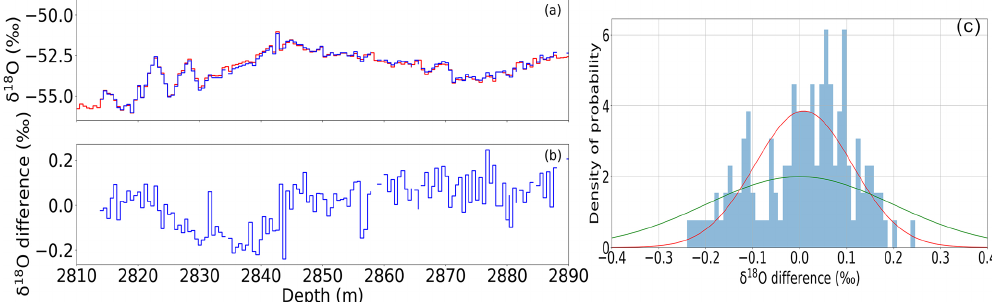
Figure 3. (a) EDC δ 18 O measurements versus depth (m) over Termination 6: measurements completed in 2010 at the University of Triestre with the CO 2 equilibration method are shown in blue, and measurements completed in 2019 at LSCE (CRDS method) are shown in red. (b) Difference between the δ 18 O values measured in 2010 and 2019. (c) Probability density function for the difference between the old (University of Triestre) and the new (LSCE) δ 18 O measurements. A Gaussian curve (red) is fitted to the data. Another Gaussian curve (green) with the standard deviation equal to the classically displayed 1 σ uncertainty of δ 18 O measurements by CRDS at LSCE (1 σ = 0.2‰) is also